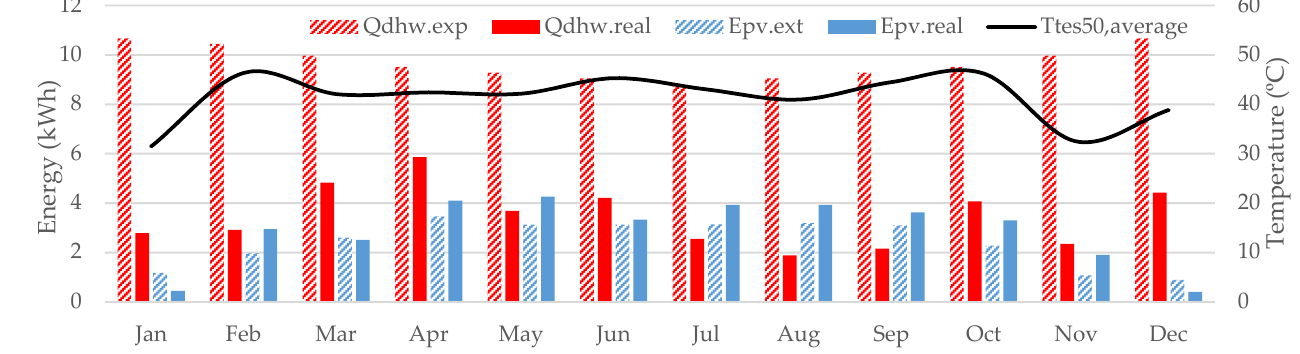
Figure 11. Day average DHW consumption, for the initially expected and finally observed values. Additionally, monthly average daily mean for TES 50 temperature.